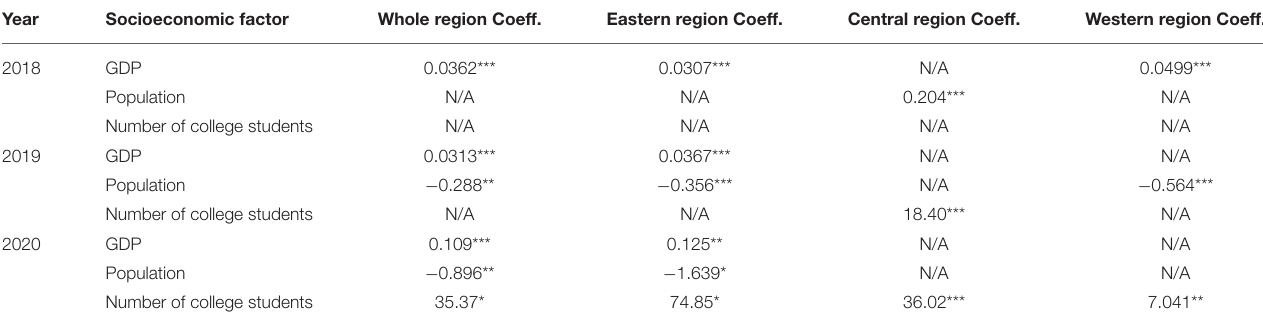
TABLE 3 | Effects of GDP, population, and number of college students on the number of participants in different regions of China in different years. Year Socioeconomic factor Whole region Coeff. Eastern region Coeff. Central region Coeff.